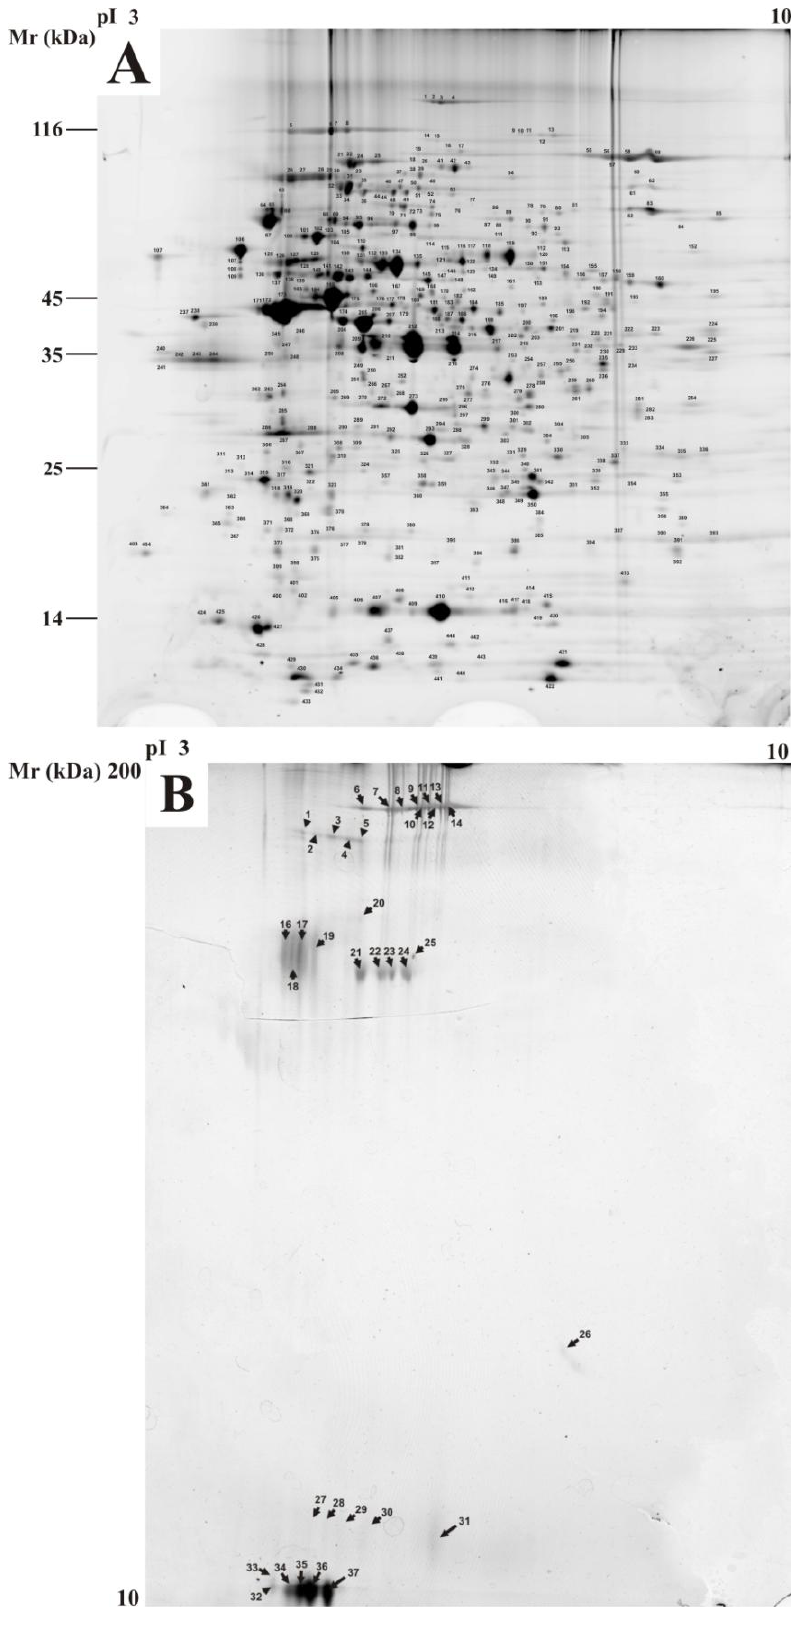
FIGURE 7. 2DE of soluble proteins from cells (A) and ultramicroforms (B) of A. laidlawii